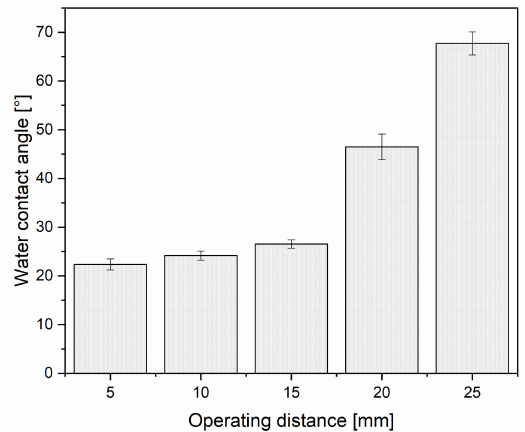
Figure 2. Water contact angle on PEEK depending on the working distance during PDD plasma treatment (18 W, 120 s, n =